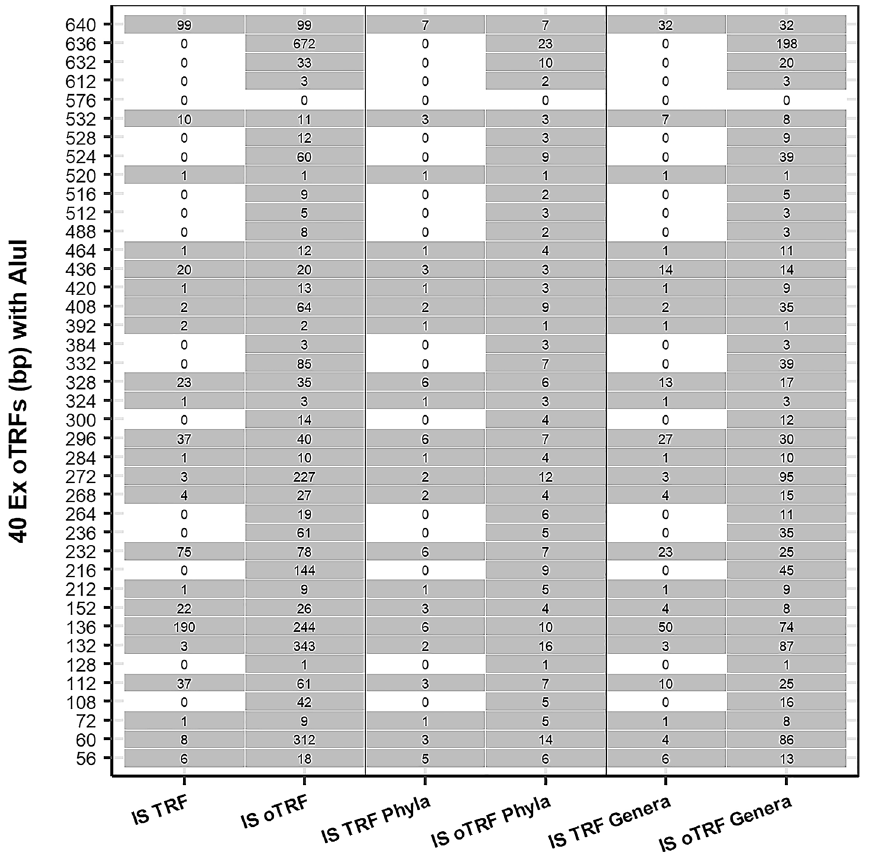
Figure 2. Tabular plot representing the FTHFS gene T-RFLP profile during comparison of 40 experimental operational terminal restriction fragment ( Ex oTRF) in base pairs (bp) versus counts of in silico ( IS ) TRF, IS oTRF and counts of taxa (phyla and genera) with restriction enzyme